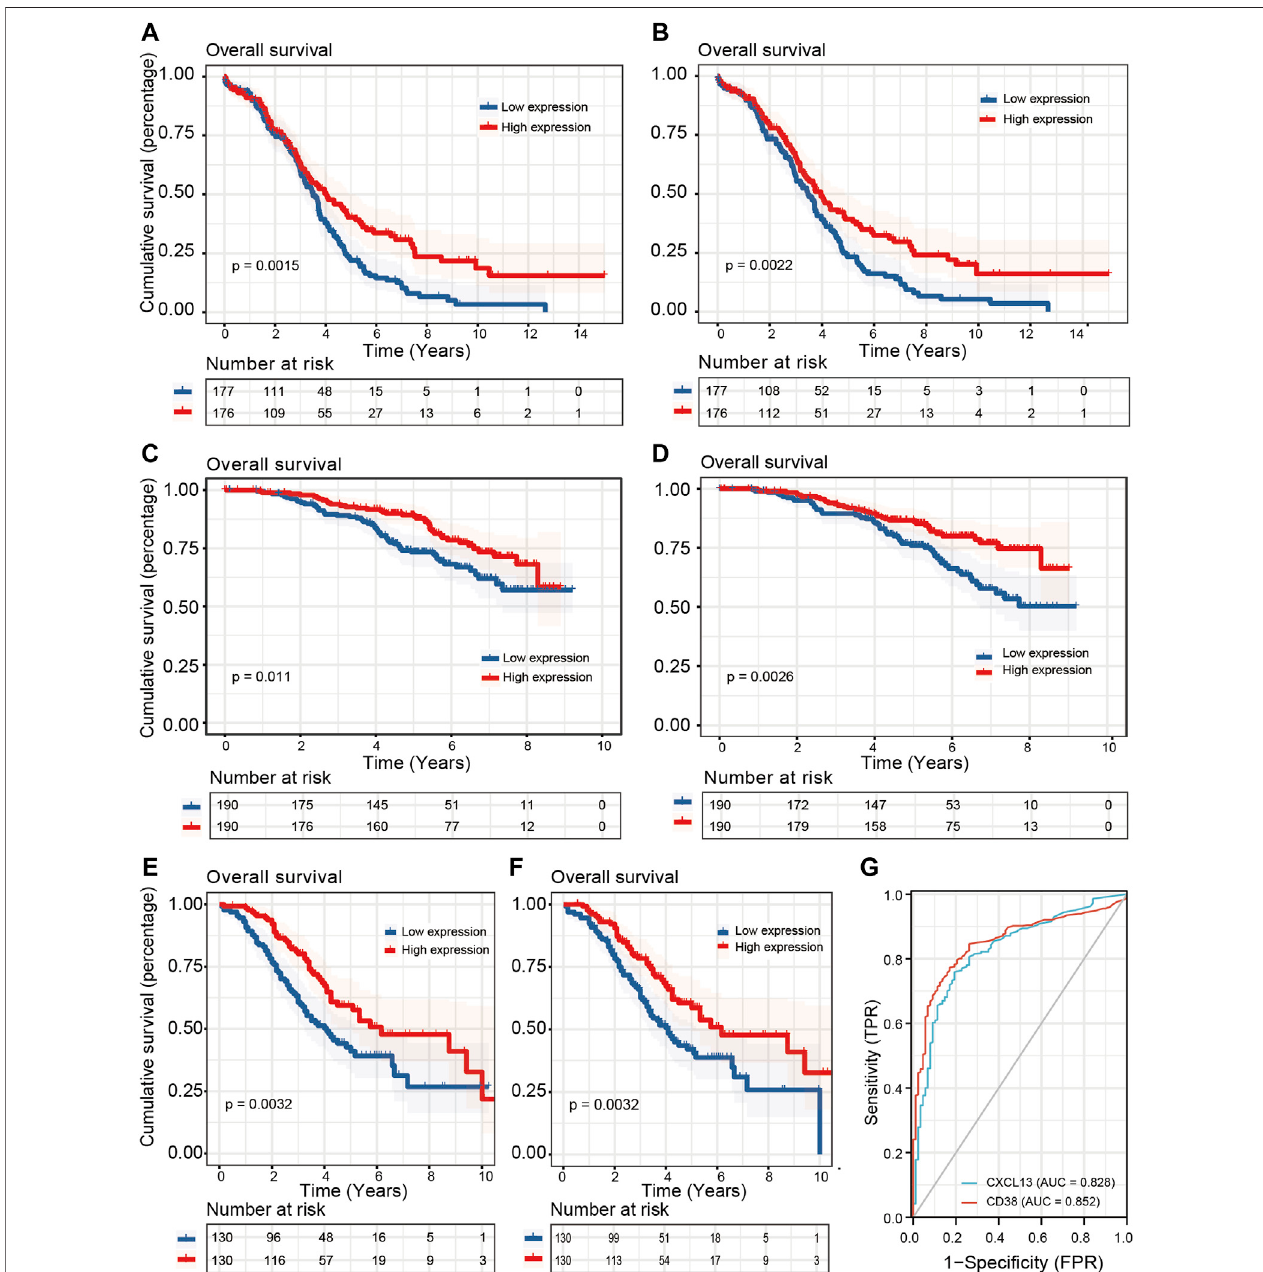
FIGURE 6 | Prognostic value and diagnostic capacity of CD38 and CXCL13 in three OC cohorts. Kaplan-Meier curves were employed to show the correlation between CD38/CXCL13 expression and OS in (A,B) TCGA-OV, (C,D) GSE140082, and (E,F) GSE32062 cohorts. (G) The ROC curve was employed to evaluate the diagnostic capacity of CD38 and CXCL13 in